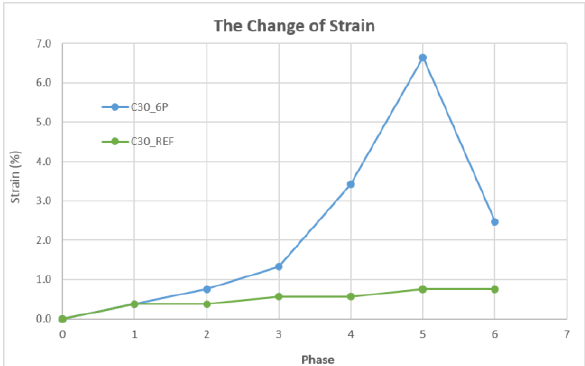
Figure 6. The change of strain for both samples with 7 scanning